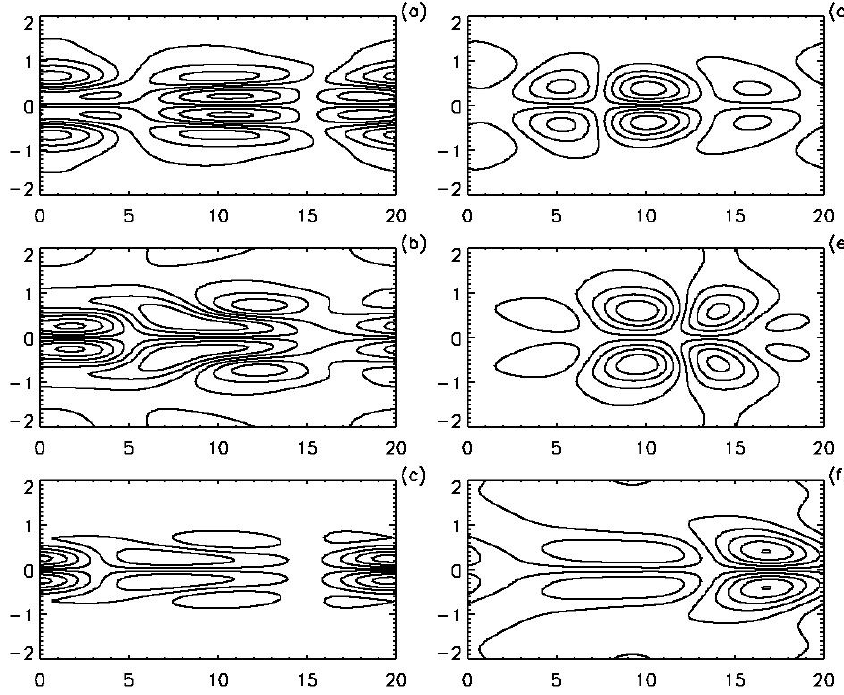
Fig. 6. Deep domain temperature contour plots for composite duct initialization. Times are 39, 54, 81, 266, 287, 311.